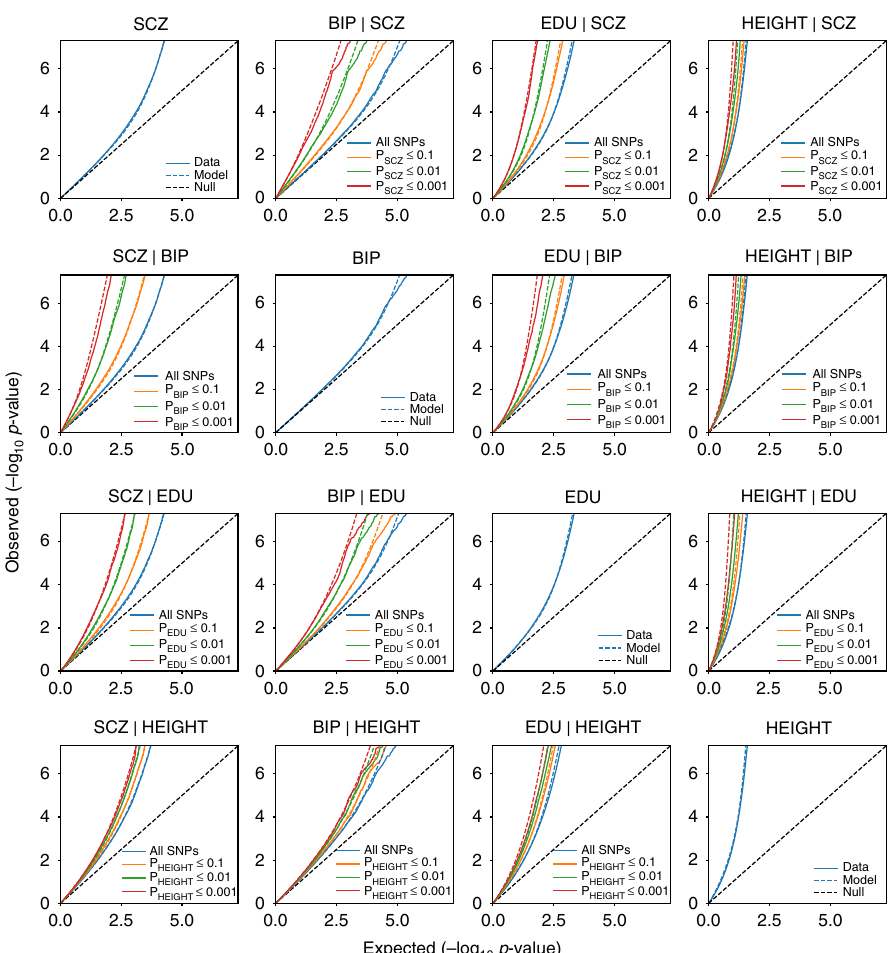
Fig. 5 Conditional Q – Q plots of observed versus expected − log 10 p -values in the primary trait as a function of signi fi cance of association with a secondary trait at the level of p ≤ 0.1 (orange lines), p ≤ 0.01 (green lines), p ≤ 0.001 (red lines). Blue line indicates all SNPs. Dotted lines in blue, orange, green, and red indicate model predictions for each stratum. Black dotted line is the expected Q – Q plot under null (no SNPs associated with the phenotype). Points on the Q – Q plot are weighted according to LD structure, using n = 64 iterations of random pruning at LD threshold r 2 =